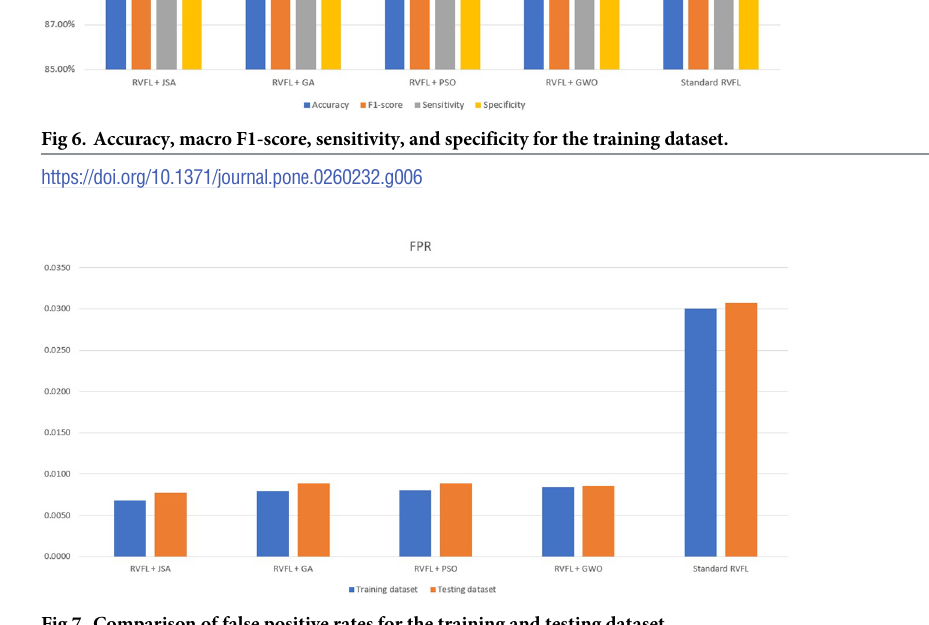
Fig 7. Comparison of false positive rates for the training and testing dataset.